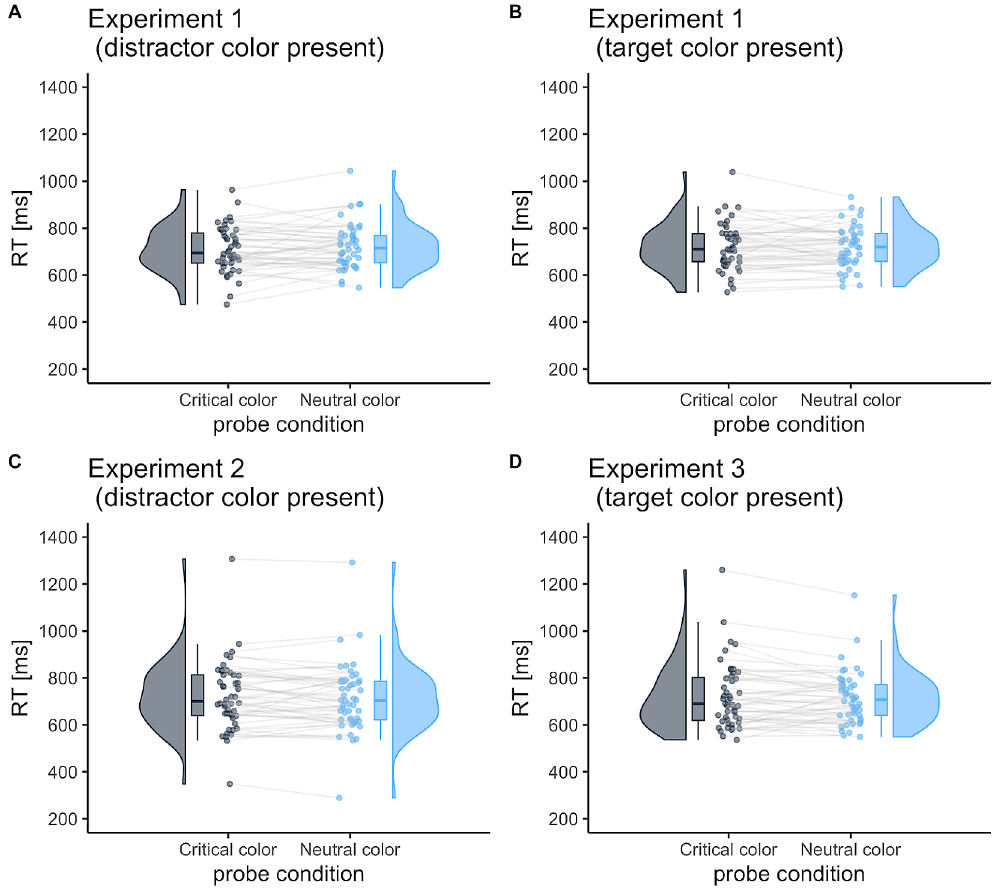
Figure 3. Mean reaction time (RT) in the probe task as a function of probe-target color. The probe-target color waseitherthecriticalcolororneutralcolor.ThecriticalcolorwaseitherthedistractorortargetcolorinExperiment1; it was always the distractor color in Experiment 2 or the target color in Experiment 3. The neutral color was one that had not been presented in search trials. Each dot represents the mean RT per participant. The box represents the interquartile range, which contains 50% of the values (median with midline), and the bottom and top edges of the whiskers represent the 1.5 (cid:1) interquartile range. Figures were drawn using the “ raincloudplots ” package in R (Allen et al. ,